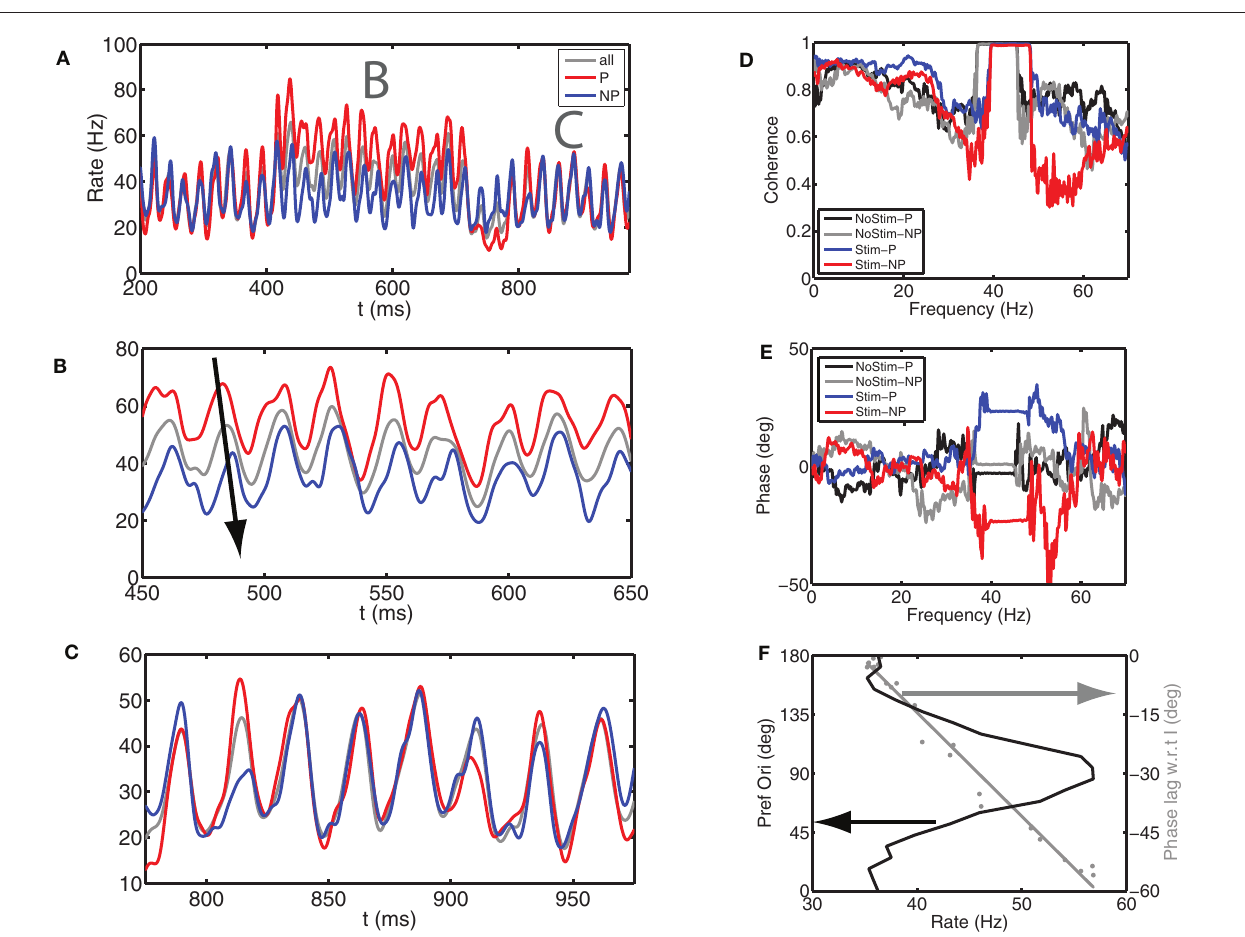
between the overall E cell population and P and NP groups has a clear peak at gamma frequencies, which shifts to higher frequencies during stimulus presentation as compared to when there is no stimulus. We show (red) All-P coherence and (blue) All-NP coherence during the stimulus, whereas All-P and All-NP coherence after the stimulus is shown in black and gray, respectively. (e) The relative phase between entire E cell population and P and NP population with the same color code as for (D) . During the stimulus period, the Ps have a negative phase indicating they are ahead of the population, whereas the NPs have a positive phase, indicating they are lagging the overall population. ( F , black curve) The E-cell firing rate in a column as a function of its preferred orientation has a bell shaped curve. Furthermore (gray curve), the spike phase relative to the peak in I cell activity varied with mean firing rate and hence was a function of the preferred orientation. The cells with the highest firing rate fired approximately 60 ° before the I cells did, whereas those with the lowest firing rate fired just before the I